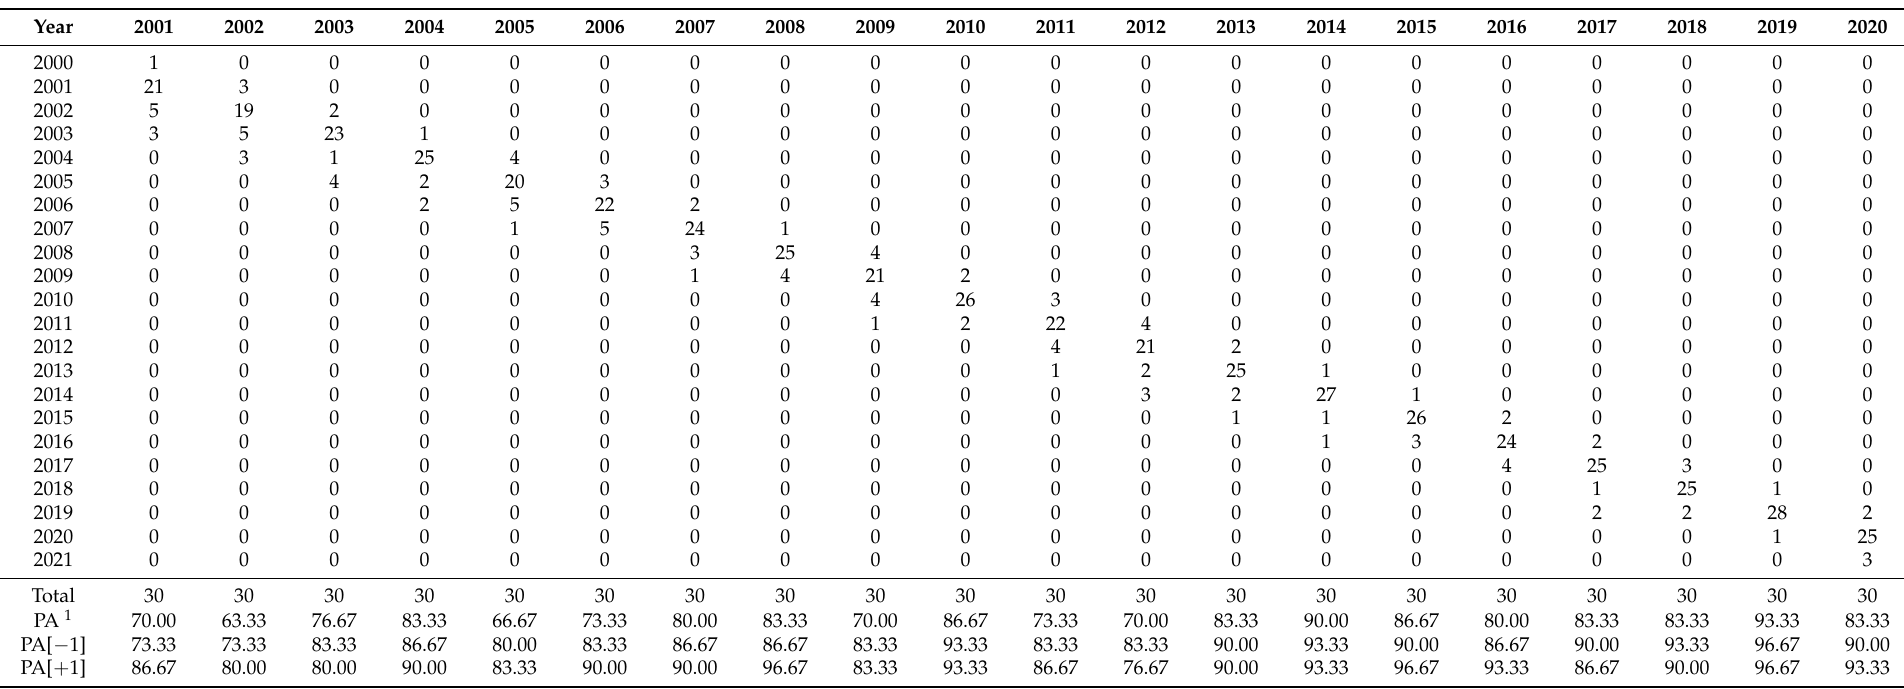
Table 5. The accuracy of the disturbance year accomplished by selecting 30 shale oil/gas well samples in Three Forks each